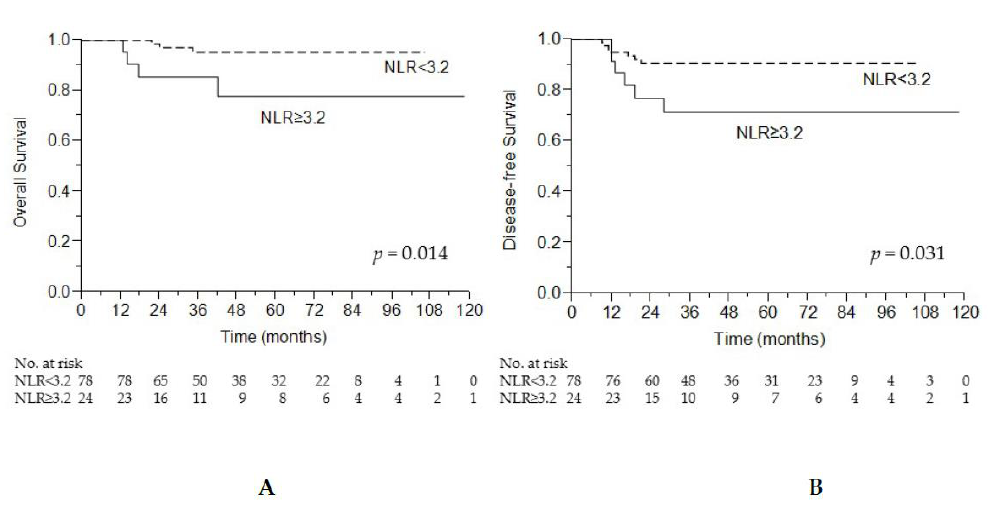
Figure 3. The area under the curve indicating optimal NLR cutoff value. ( A ) AUC for overall survival, ( B ) AUC for disease-free survival.